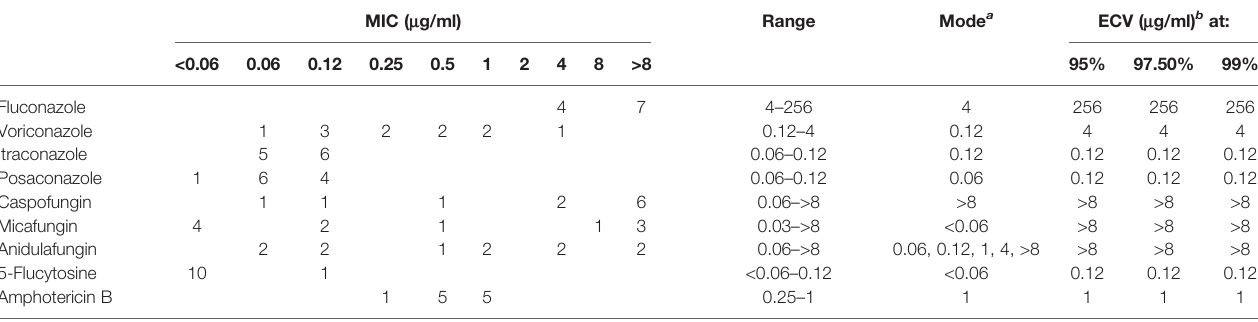
TABLE 2 | Epidemiological cutoff values (ECV) of nine antifungal agents based on aggregated minimum inhibitory concentration (MIC) distributions of Diutina catenulata . MIC ( m g/ml) Range Mode a ECV ( m g/ml) b at: